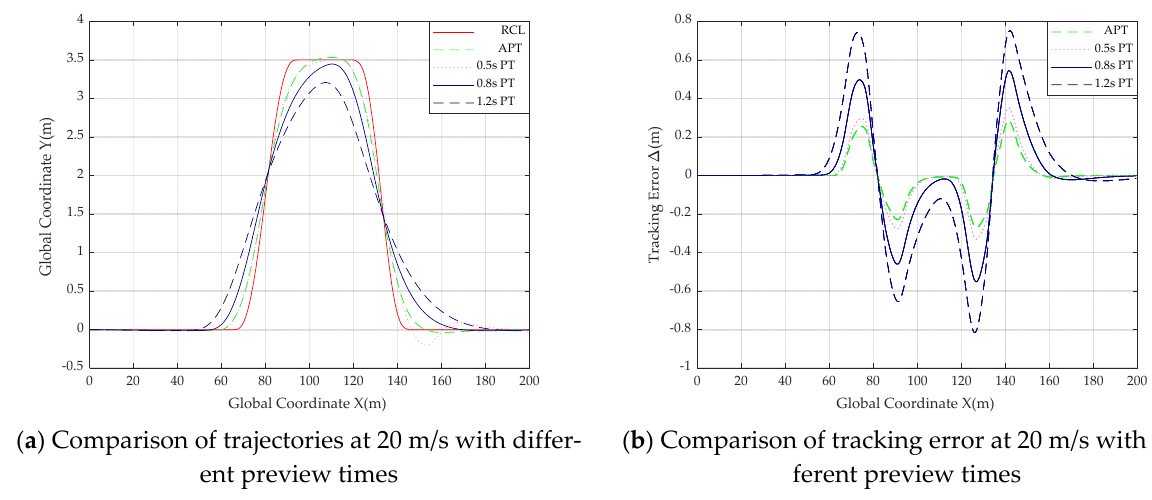
Figure 21. Comparison of trajectories and tracking error with different preview times at 15 m/s.